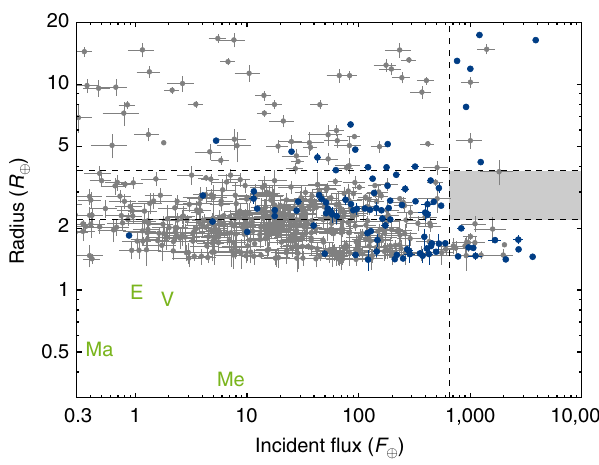
Figure 7 | Radius-flux diagram showing the debiased seismic subsample. The debiased sample of exoplanets with a threshold SNR of 10 and a radius fulfilling R min o R x o R p with R x ¼ 1.4 R " is shown (in blue) with 1 s errorbars. The grey points are all the exoplanets in the non-seismic sample fulfilling R min o R x o R p , also with 1 s errorbars. The location of the four rocky solar system planets; Mercury (Me), Venus (V), Earth (E) and Mars (Ma) is shown with the green writing for reference. The vertical dashed line shows where the incident flux is equal to 650 F " , while the horizontal dashed lines indicate radii of 2.2 and 3.8 R " respectively. The location of the hot-super- Earth desert has been